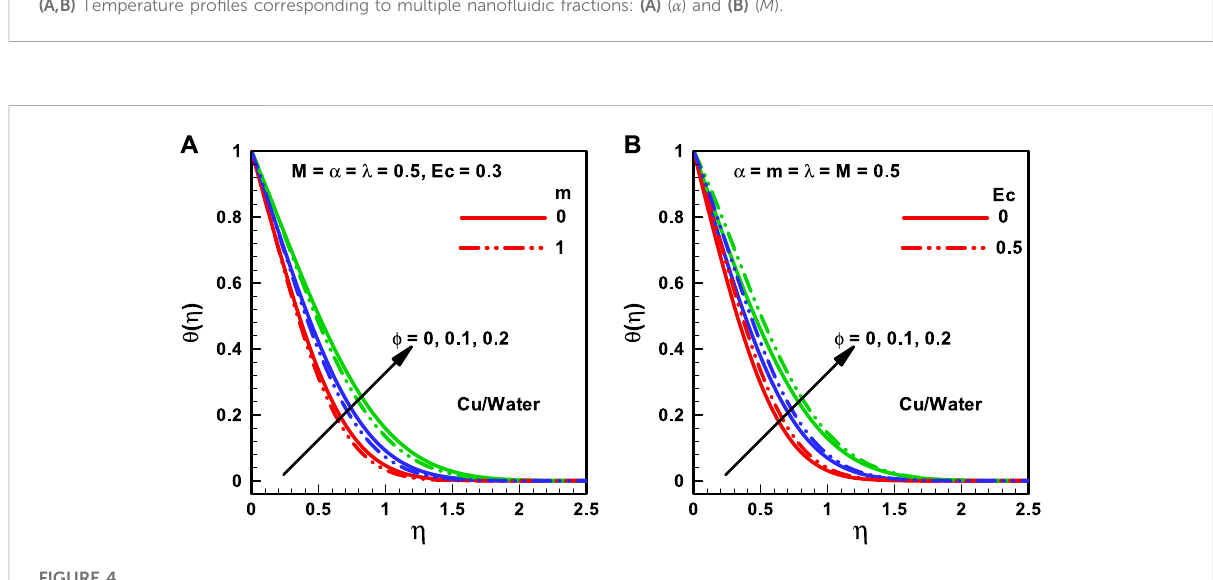
FIGURE 4 (A,B) Temperature pro fi les corresponding to multiple nano fl uidic fractions: (A) ( m ) and (B) ( Ec